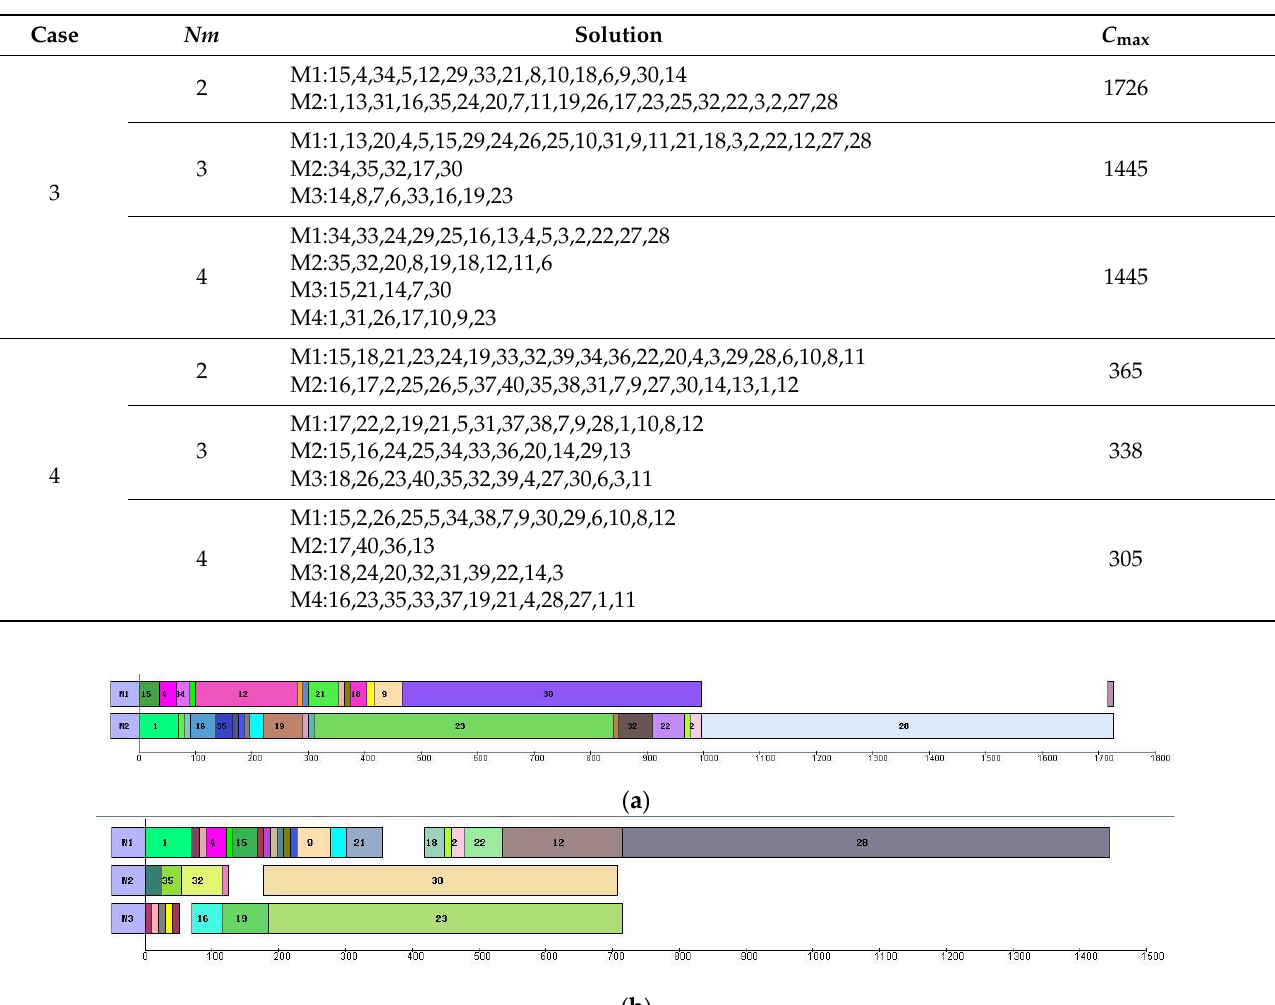
Table 4. Best Solutions for cases 3–4 with 2–4 Manipulators.